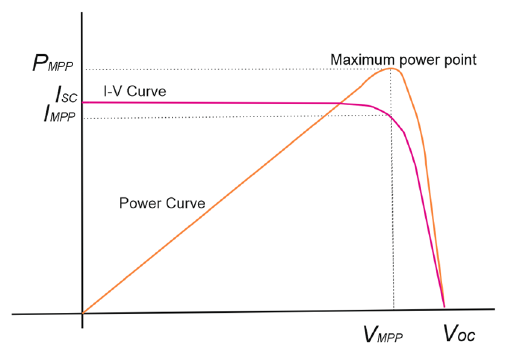
Figure 1. I–V characteristic